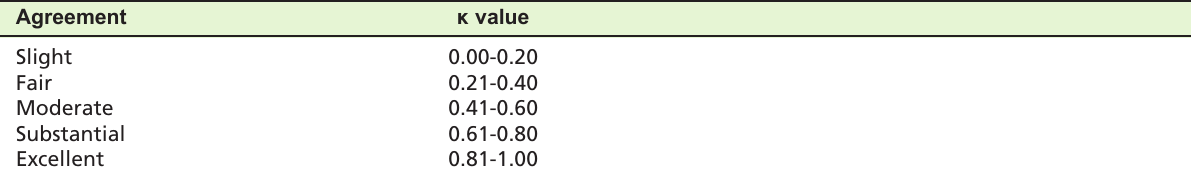
Table I: Categorisation of agreement as originally described by Landis and Koch 15